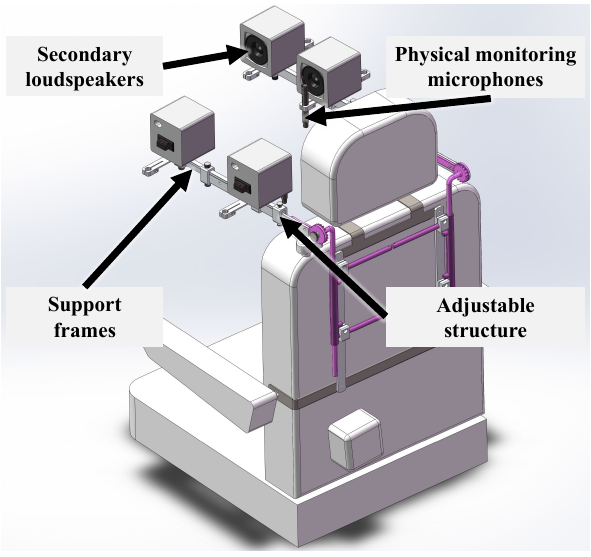
Figure 1. The 3D design model of the proposed manually adjustable headrest structure for